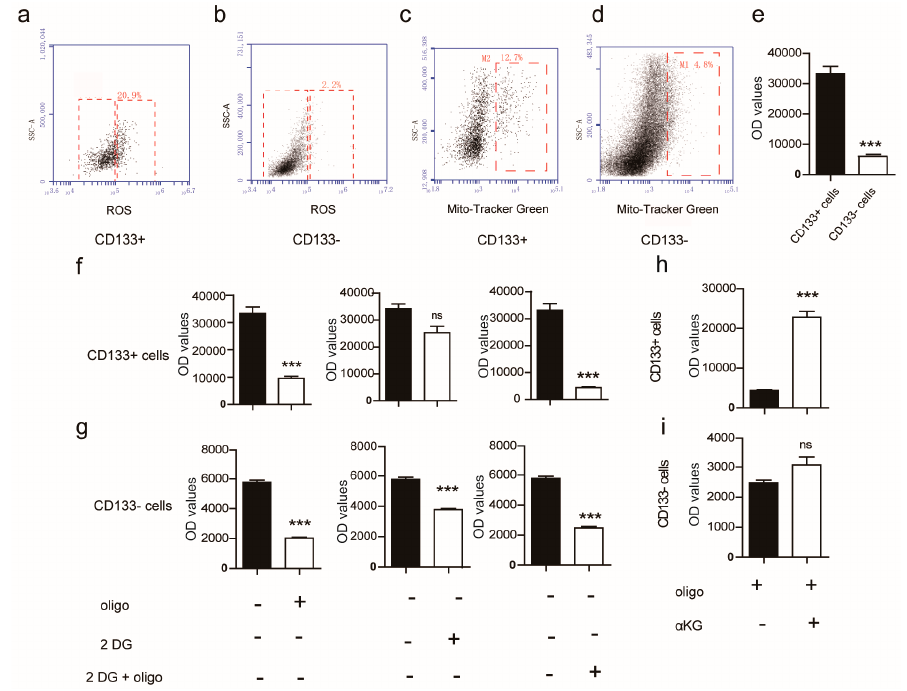
Figure 2. The analyses of mitochondria function in CD133 + /CD133 − cells. ( a , b ) dot plot of reactive oxygen species (ROS) expression in CD133 + /CD133 − cells was measured by flow cytometry; ( c , d )